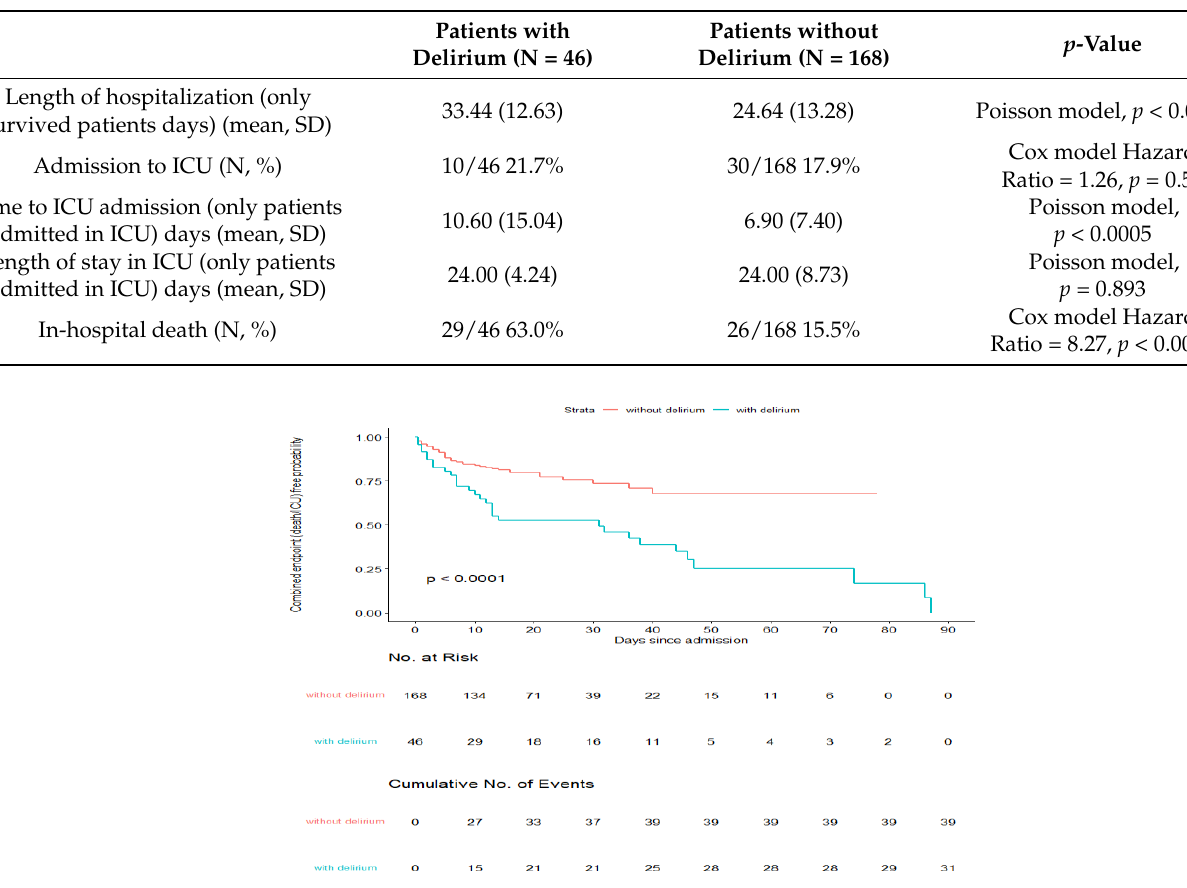
Table 5. Association between delirium and outcomes.